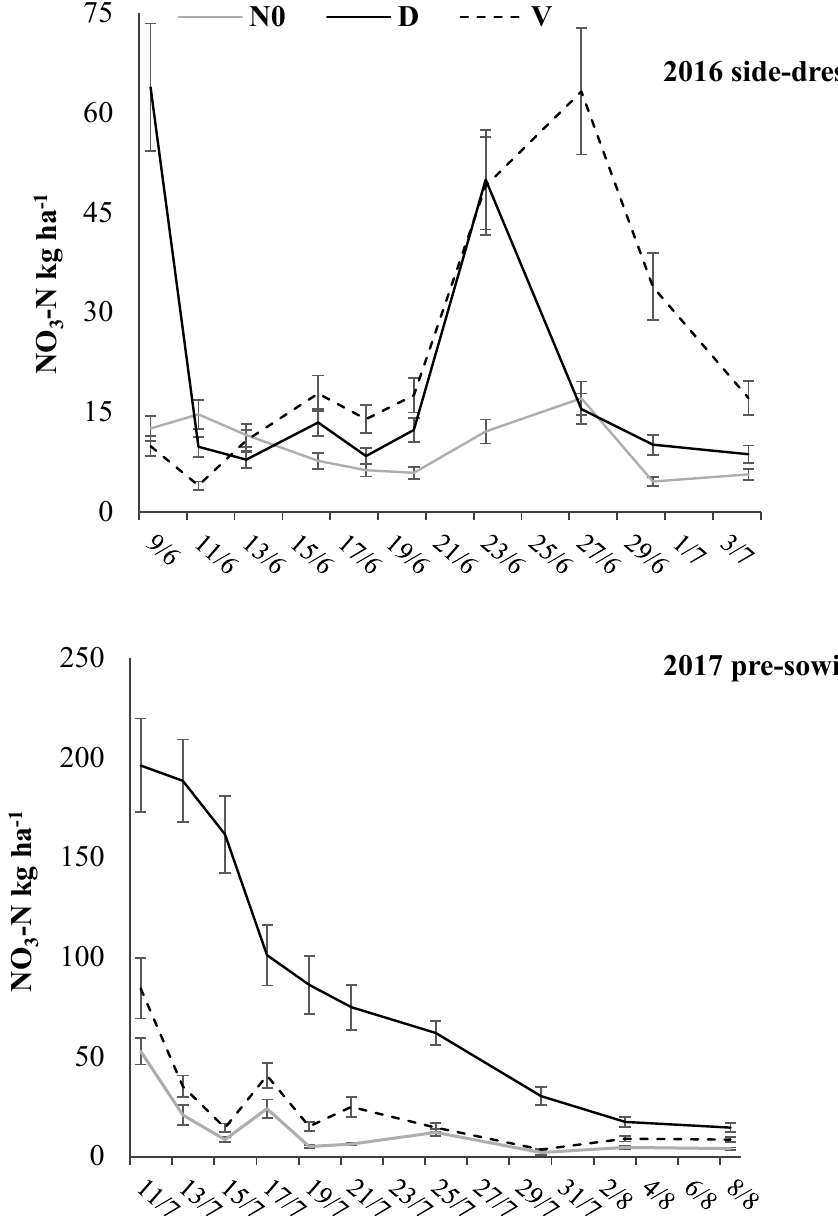
Figure 4. NO 3 -N content in the soil (kg NO 3 -N ha − 1 ) during side-dressing (“2016”, upper panel) and pre-sowing (“2017”, lower panel). Non-fertilized plot (N0), digestate injection (D) and digestate + DMPP injection (V). The displayed data were calculated as mean across the three blocks. Error bars represent mean standard error, ±.